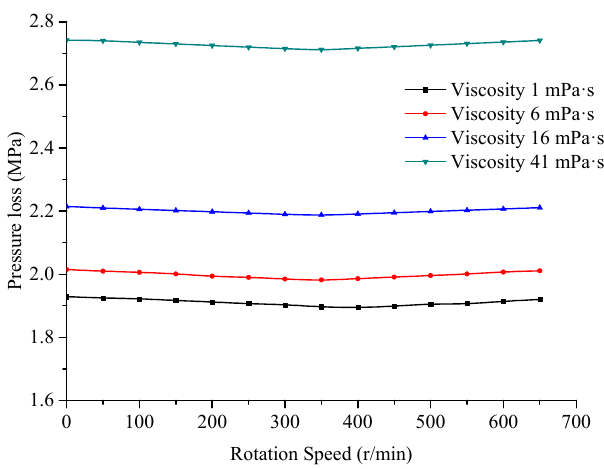
Figure 11. Pressure drop vs. speed curves for different viscosities. The effect of the drilling fluid viscosity on the turbine-level torque and power is consistent. Based on Formula (24), the influence of the viscous fluid relative to the ideal fluid is the assumed function F ( µ ). The flow of the three-dimensional viscous fluid along the axis of the turbodrill and the centrifugal rotation relative to the blade are very complicated. Figure 12 is a numerical simulation curve of torque vs. speed under different viscosities, and Figure 13 is a numerical simulation curve of power vs. speed.